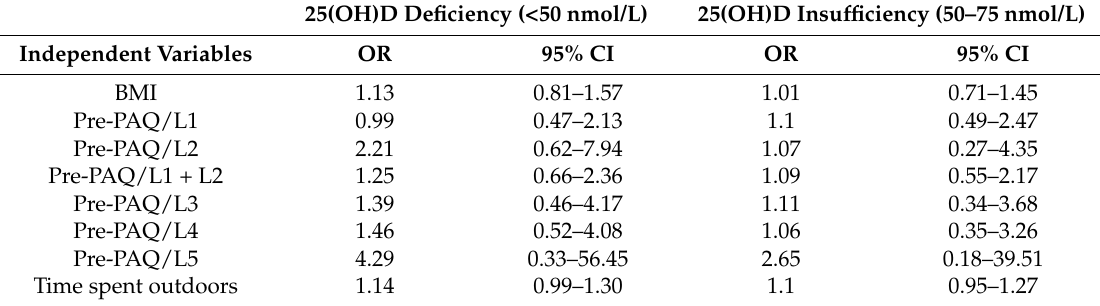
Table 5. Correlates of the 25(OH)D level in girls ( n = 128). 25(OH)D sufficiency (>75 nmol/L) was used as the reference